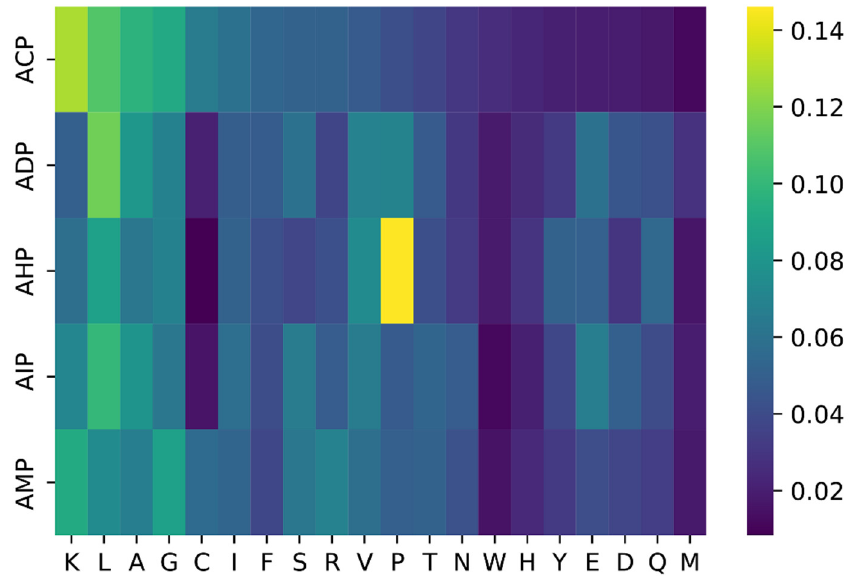
Figure 3. Hot map of amino acid distribution of five types of bioactive peptides.